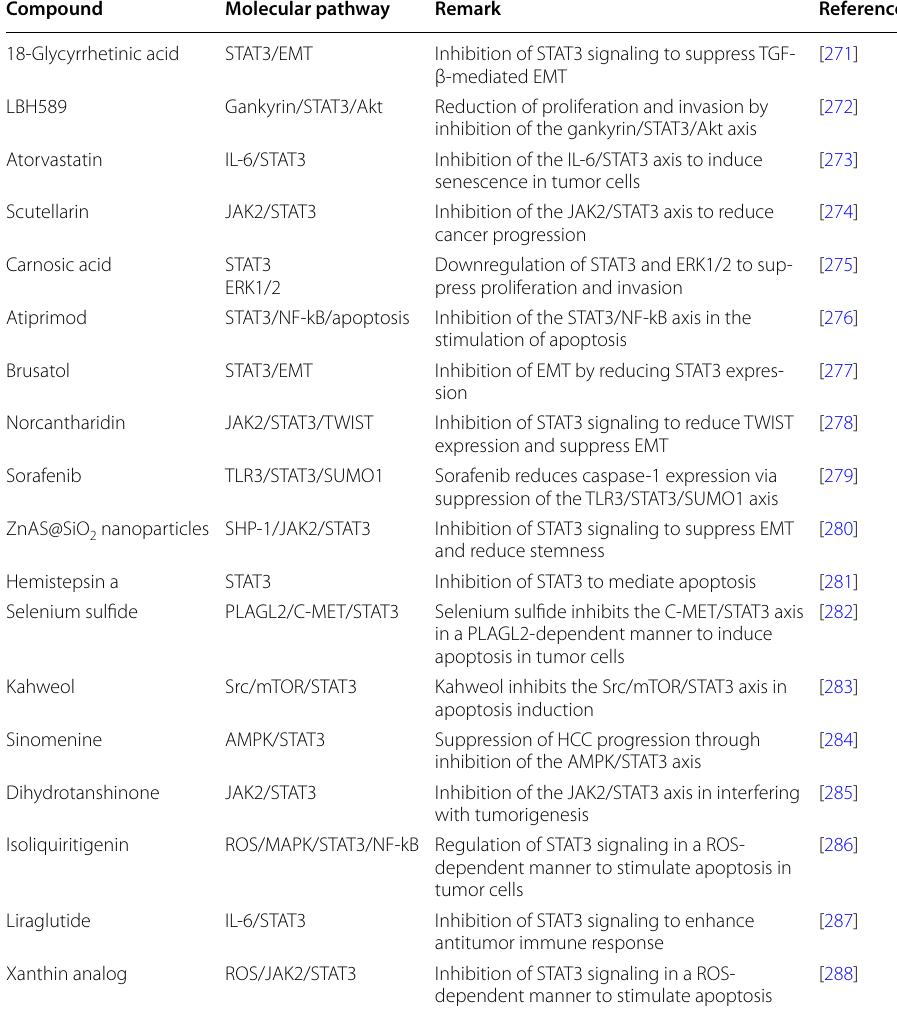
Table 5 The antitumor compounds targeting STAT3 signaling in HCC therapy Compound Molecular